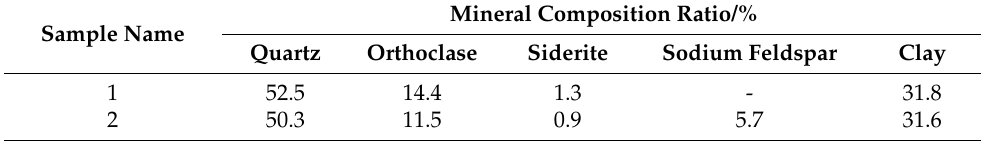
Figure 5. XRD patterns of muddy sandstone samples ( a ) 1 and ( b ) 2. Table 1. Composition of rock components.